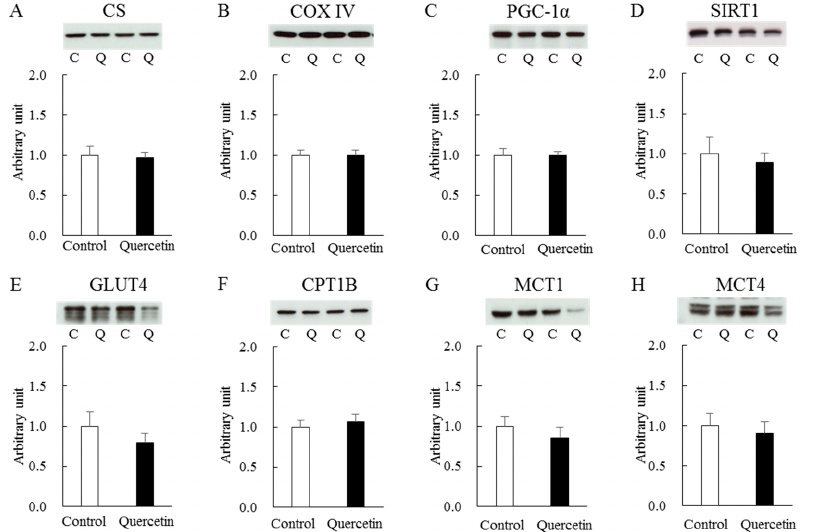
Figure 5. Effects of 7-day quercetin treatment on metabolic molecules in epitrochlearis muscles. Rats were assigned to either a control or quercetin groups and were maintained under ad libitum feeding for 7 days. After that, epitrochlearis muscles were dissected out as Western blot samples for CS ( A ), COX IV ( B ), PGC-1 α ( C ), SIRT1 ( D ), GLUT4 ( E ), CPT1B ( F ), MCT1 ( G ) and MCT4 ( H ). A representative blot is shown above each figures. Values are means ± SE ( n = 6–13). All values were normalized by GAPDH abundance. C: control, Q: